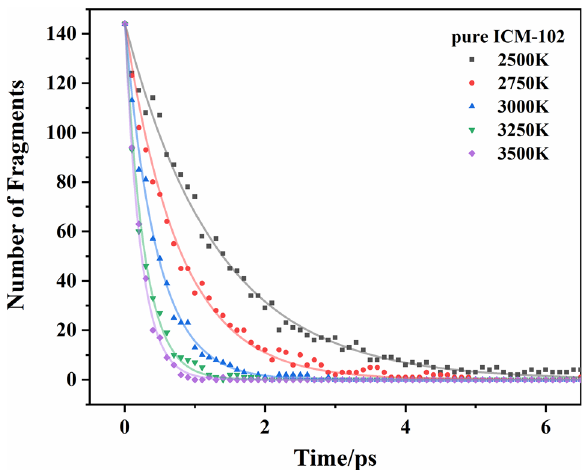
Figure 7. Change of the number of ICM-102 molecules with time in the pure ICM-102 system at different temperatures. The lines are the fitted curves.